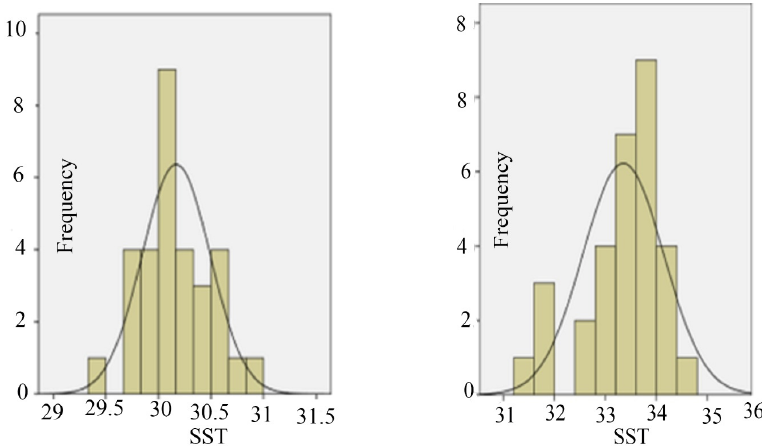
Figure 9. The frequency of the surface temperature of water in August 2008 ( Left ) and 2009 ( Right ).